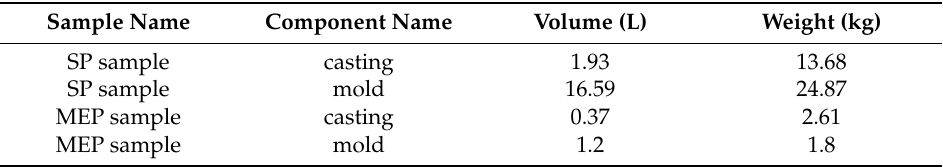
Table A4. Properties of the casting components in the numerical simulation.